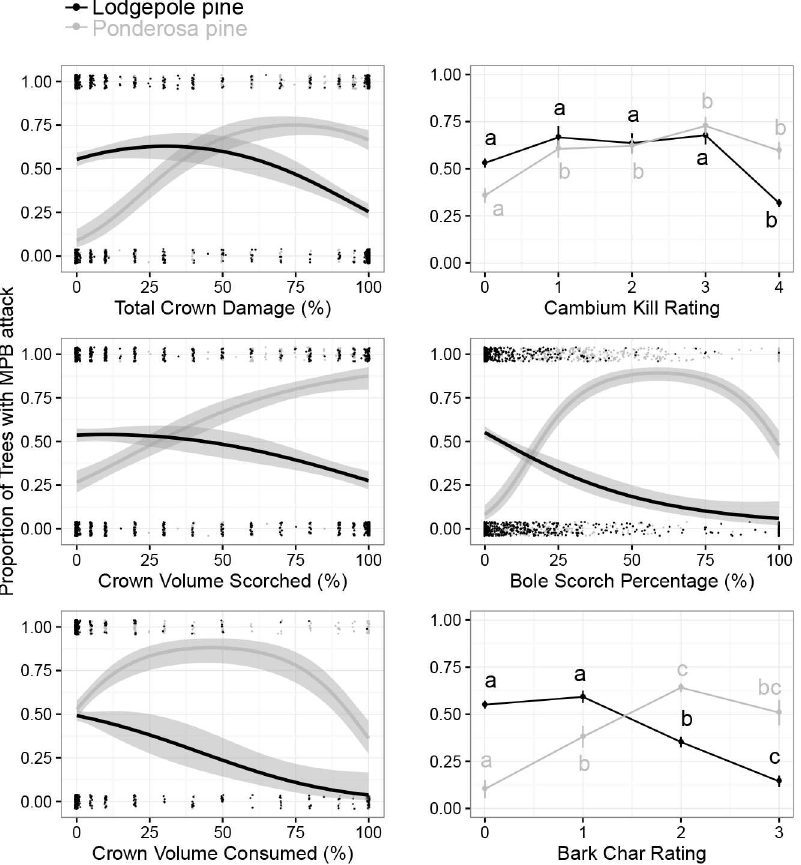
Fig 6. Relationship between proportion of trees with mountain pine beetle attacks (all attack types) and fire injury. Generalized linear models representing the probability of MPB attack on lodgepole and ponderosa pines within 3 years post-fire for four continuousand two categoricalmeasures of fire injury. Models for each continuous measure were alloweda polynomialterm, although in some cases these terms were not significant. For categoricalmeasures, different letters indicate significant differences ( α (cid:20) 0.05) among severities of fire injury from Tukey HSD pairwise comparisons. All data were modeled with a binomial distribution and all models were globallysignificant as measured with likelihoodratio tests. Model parametersin S4 and S5